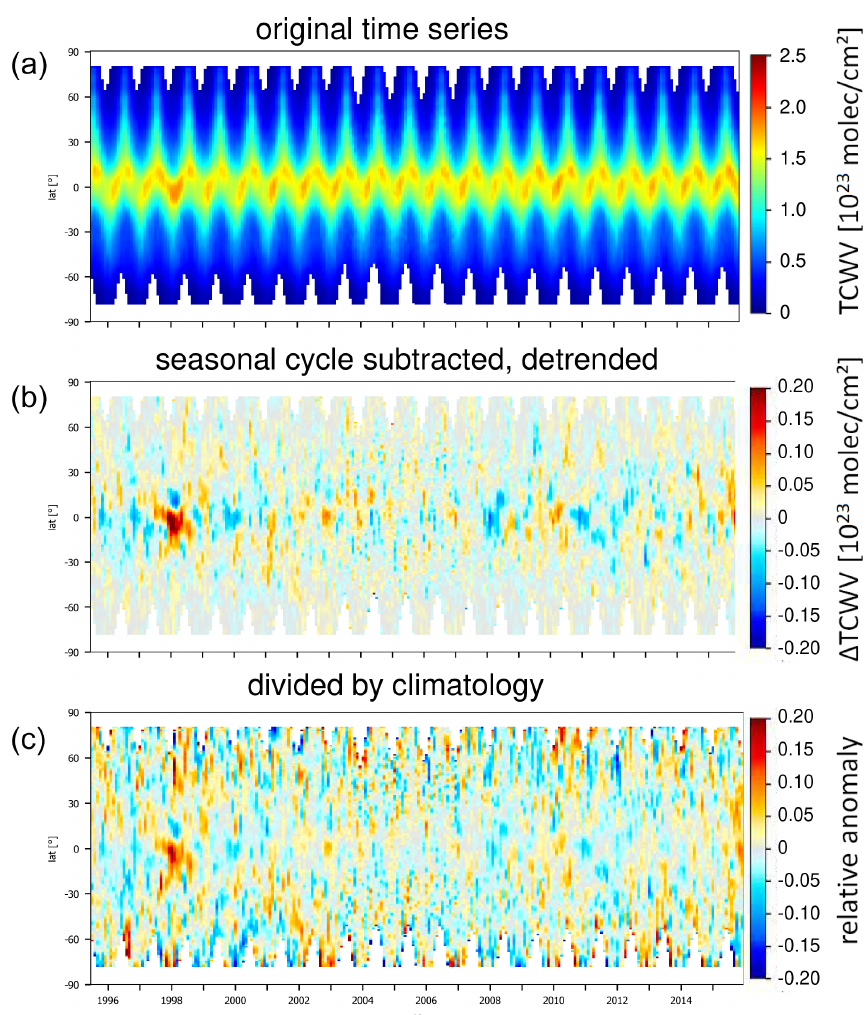
Figure 1. (a) TCWV measured from satellite as a function of time and latitude (zonally averaged values) on a 1 ◦ × 1 ◦ latitude–longitude grid with monthly resolution; (b) (absolute anomalies) after the mean seasonal cycle and a linear trend was subtracted; (c) relative anomalies (absolute anomalies divided by the corresponding monthly mean